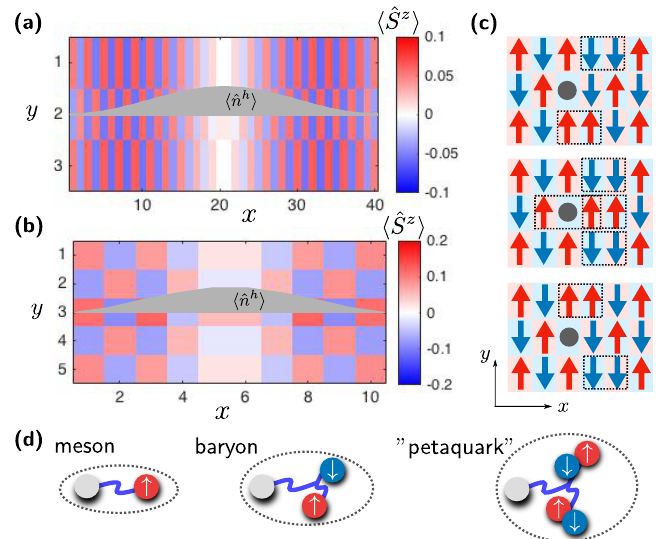
Figure 6: Precoursors of stripe formation. We consider a single hole moving on the central chain of an n -leg ladder, described by the mixD t − J model with with open boundary conditions. We performed DMRG simulations for (a) an n = 3-leg system = 40 sites in x -direction and (b) n = 5 and L = 10. The hole density with L x x 〈 ˆ n h 〉 forms a standing wave pattern with a pronounced maximum in the center of the j = ( − 1 ) j x + j y 〈 ˆ S z 〉 changes sign in middle chain (gray). The AFM order parameter Ω j j = L / 2. To understand this pattern from a parton perspective, the center around j x x one needs to consider multi-parton bound states. (c) In a three-leg ladder, the holon is bound to two spinons (domain walls) in the upper and lower chains. The possible spinon configurations (top and bottom) are coupled via a third state (center) with a spin-1 magnon excitation in the central chain. (d) The multi-parton state in the three- leg ladder is a generalization of a meson and can be understood as the analogue of a baryon. Similarly, the bound state in a five-leg ladder corresponds to a petaquark